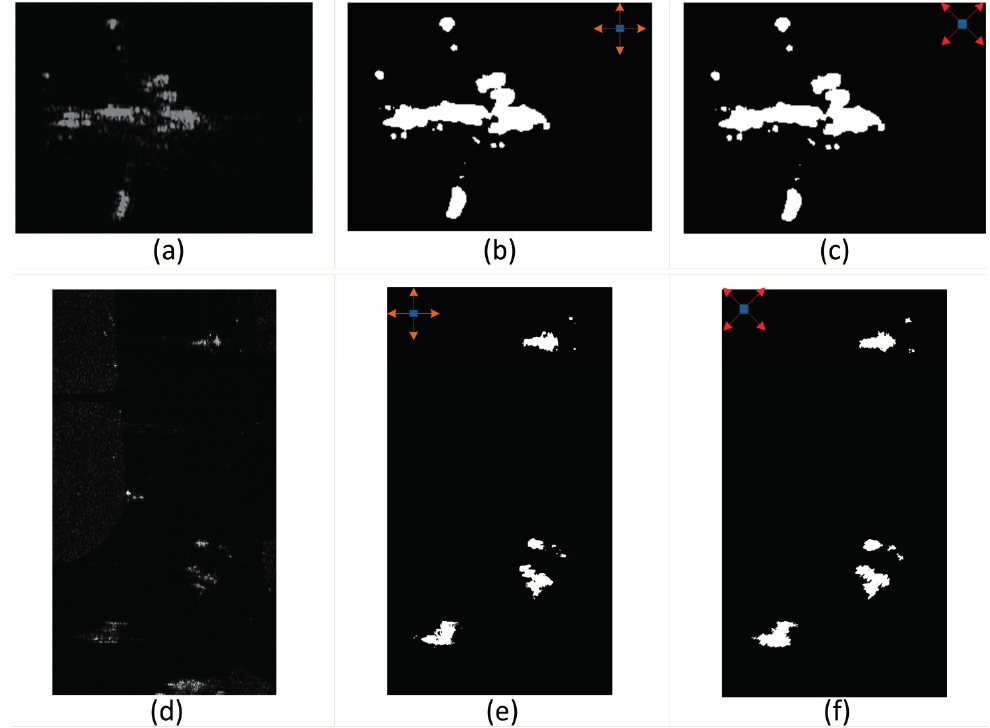
Figure 7. ROC curves of the two groups of directions. The red one is the ROC by using window of 0°–270° with 90° interval; the blue one is the ROC curve by using window of 45°–315° with 90° interval.